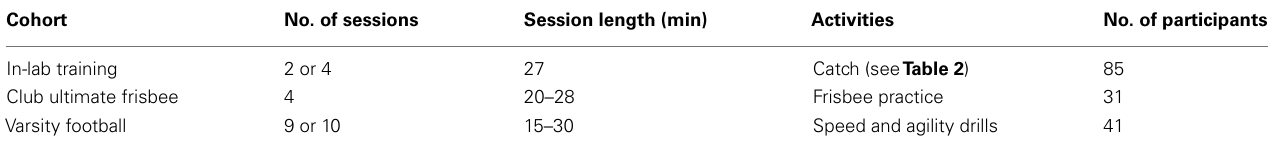
Table 1 | Summary of training cohorts.